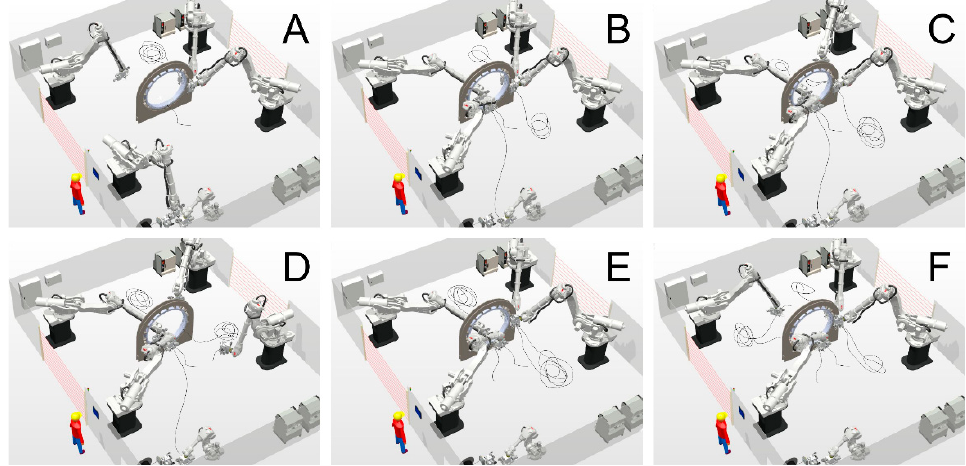
Figure 5. Graphical illustrations of the simulated robotized stator cable winding process with S2c, with winding robot pair one (RP1) to the left and winding robot pair two (RP2) to the right. The process is repeated until the full stator is wound. Note that the cable positioning is only from process illustration. ( A ) The lower robot in RP1 fetches a prepared cable from the drum, and RP2 is positioned to start feeding through a new slot hole. ( B ) RP1 is positioned to start feeding through a new slot hole and RP2 has started to feed cable. ( C ) RP1 has started to feed cable and the lower robot in RP2 is pulling the end winding as the upper robot has dropped the cable. ( D ) RP1 has fed most of the cable, and the lower robot in RP2 is finding the cable end by feeding the cable backwards out on the floor. ( E ) The lower robot in RP1 has dropped the cable as it is cut off at the drum, and RP2 is positioned to feed through a new slot hole. ( F ) The upper robot in RP1 is finding the cable by feeding the cable backwards out on the floor end and RP2 has started to feed the cable.